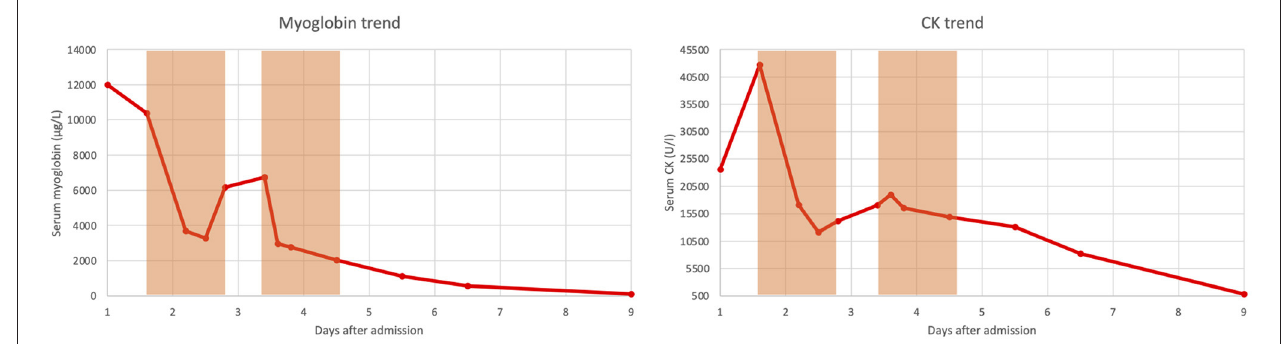
FIGURE 1 | Trend of serum myoglobin and serum creatinine kinase (CK) over time. The light orange boxes denote the periods in which continuous veno-venous hemodiafiltration combined with Cytosorb ® was